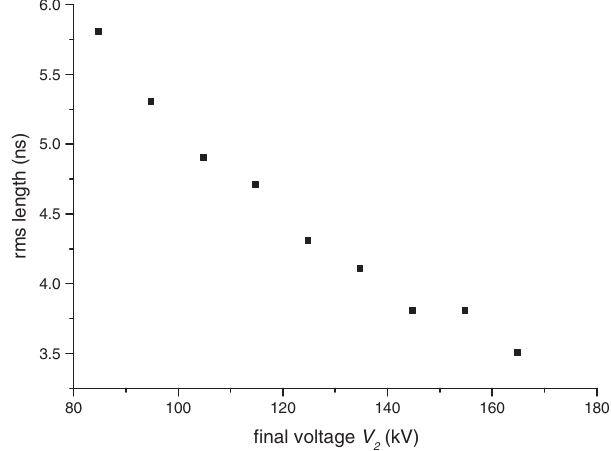
FIG. 7. The rms extraction bunch lengths with different final voltages in mode